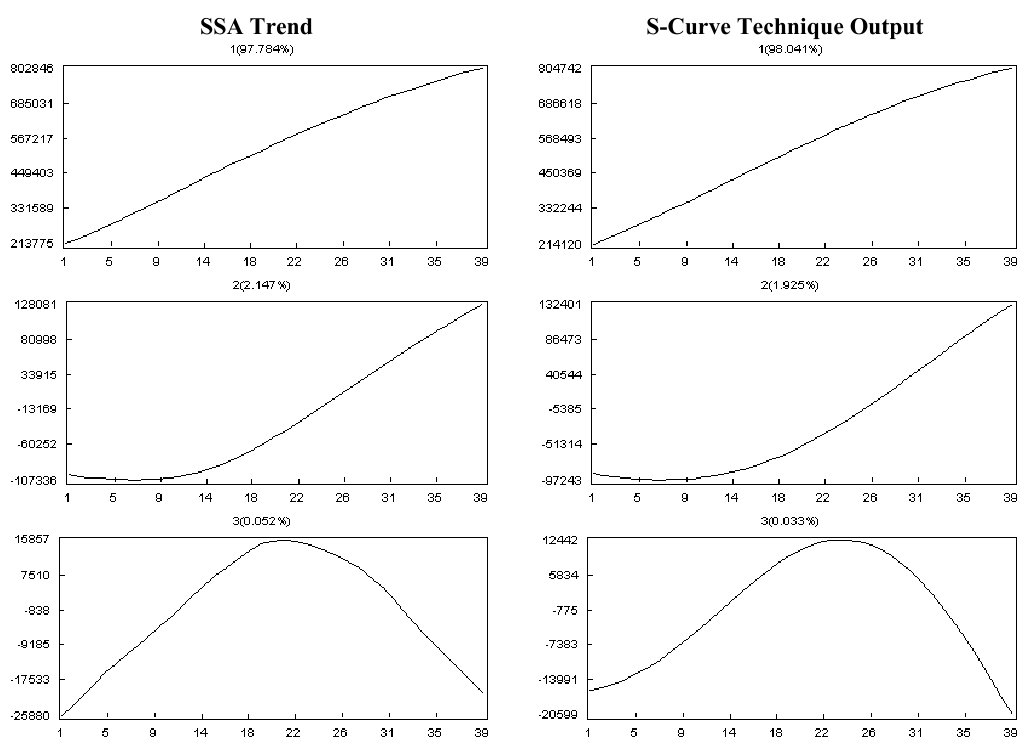
Figure 14. Principal components related to the first three eigentriples.